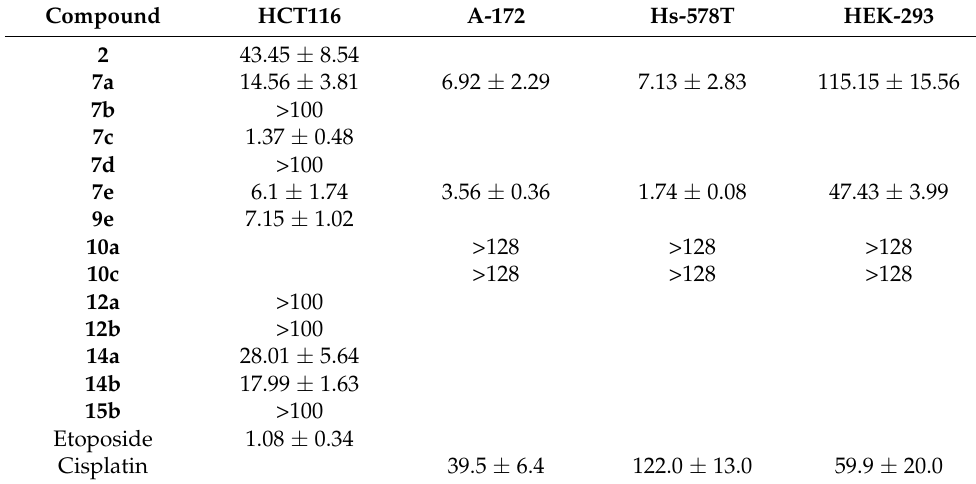
Table 1. Cytotoxicity index (IC 50 ) on colorectal cancer (HCT116), glioblastoma (A-172), breast ductal carcinoma (Hs578T), and normal human embryonic kidney (HEK-293) cells for compounds 2 , 7a – e , 9e , 12a – b , 14a – b , and 15b , µ